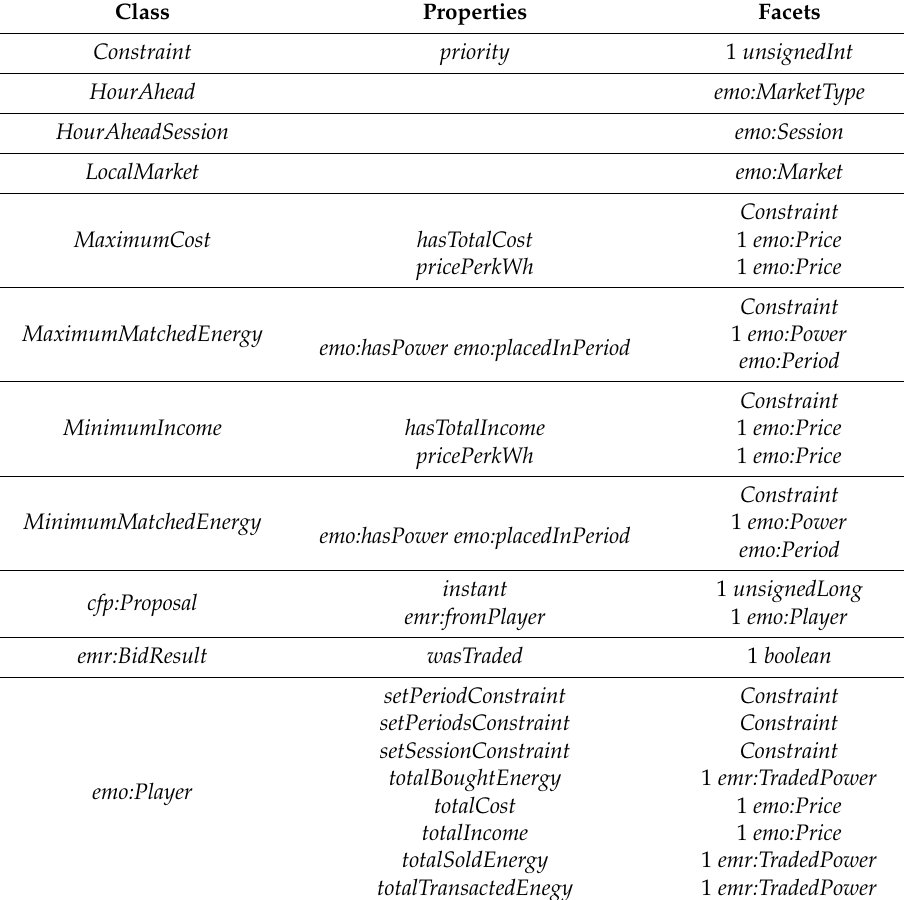
Table 1. Local Market Ontology (LMO)’s classes, properties, and